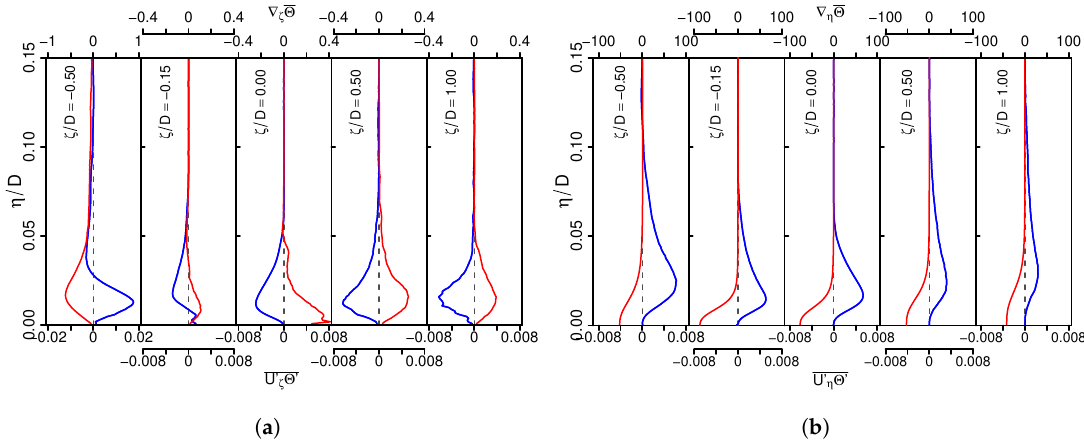
Figure 6. Wall-parallel ( a ) and wall-normal ( b ) components of the turbulent heat flux vector and mean temperature gradient at different wall-normal traverses. ( ): mean temperature gradient ∇ i Θ ; ( ): Θ (cid:48) turbulent heat flux vector U (cid:48) i